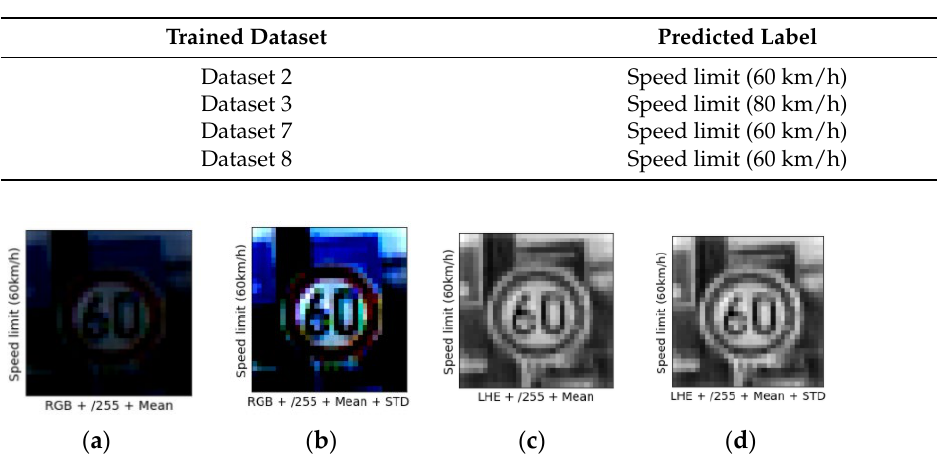
Table 6. Comparison of datasets to predict an unknown dataset of different labels [2,25].